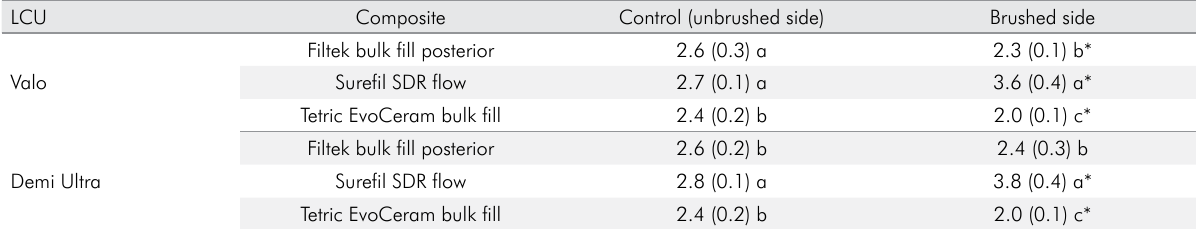
Means (SD) followed by different letters indicate a significant difference by three-way repeated measures ANOVA and post-hoc Tukey’s test (p < 0.05). Lowercases compare resin composites for the same light and the same treatment (unbrushed or brushed). *Indicates difference from the control (unbrushed)